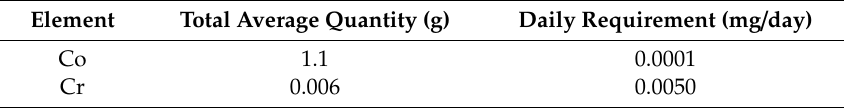
Table 4. Amounts of Co and Cr for an adult human